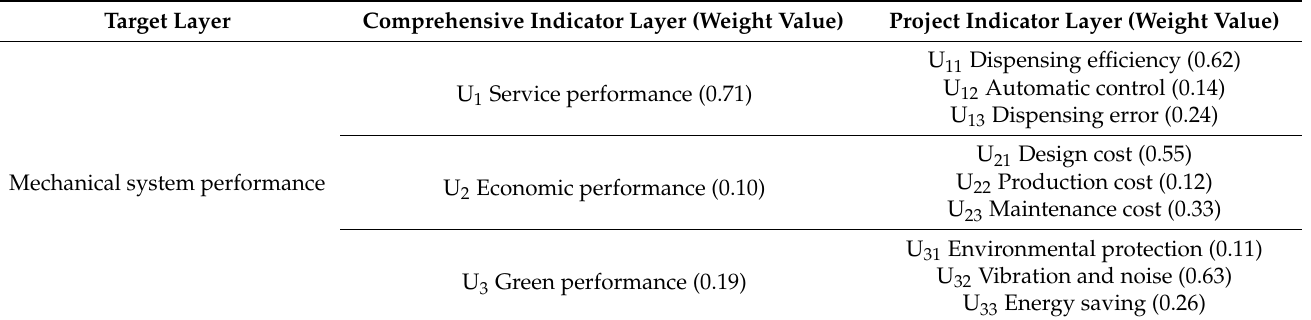
Table 13. Evaluation indicator